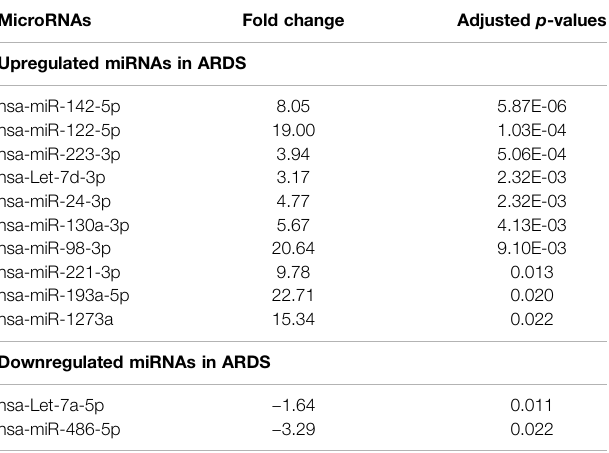
TABLE 2 | Differentially expressed exosomal miRNAs among HSs and ARDS patients in the discovery cohort. MicroRNAs Fold